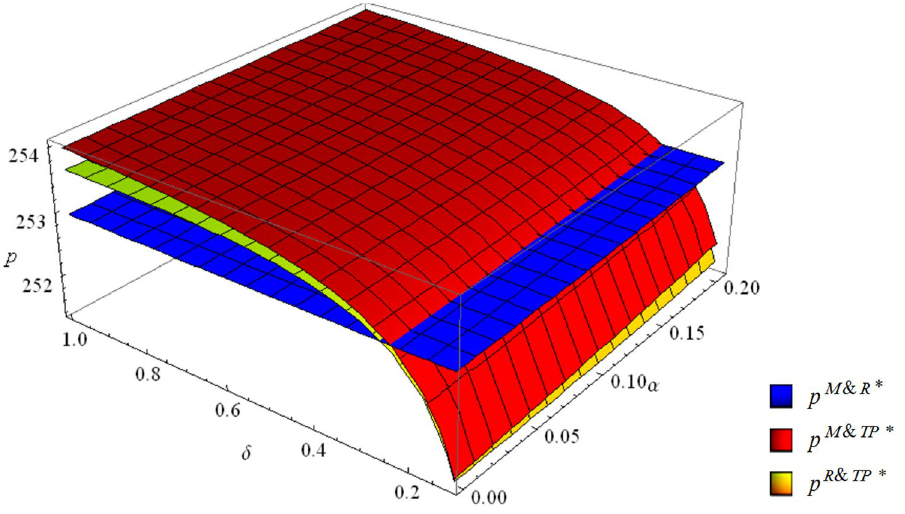
Figure 2. The retail prices in the three collection